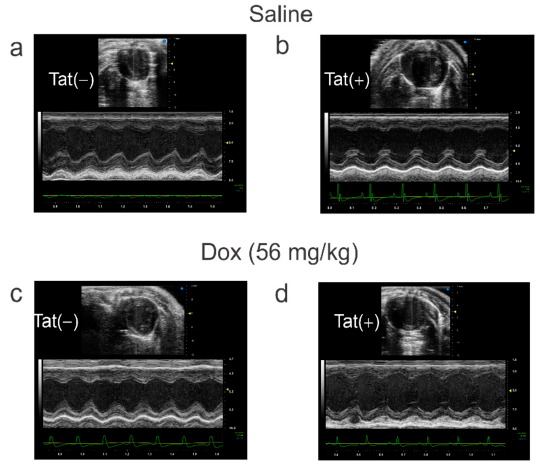
Figure 3. Two-Dimensional Echocardiographic Images Measured by Ultrasound. Tat expression did not alter cardiac function among adult Tat-transgenic mice [Tat(+)] compared to their non-Tat- expressing age-matched counterparts [Tat( − )]. ( a ) Tat( − ) mice treated with saline, ( b ) Tat(+) mice treated with saline, ( c ) Tat( − ) mice treated with Dox, ( d ) Tat(+) mice treated with Dox. Table 1. Morphological and cardiac functional assessments by echocardiogram parameters includ- ing brightness- (B-mode) and motion-mode (M-mode) measurements among HIV-1 Tat transgenic mice treated with saline or Dox.